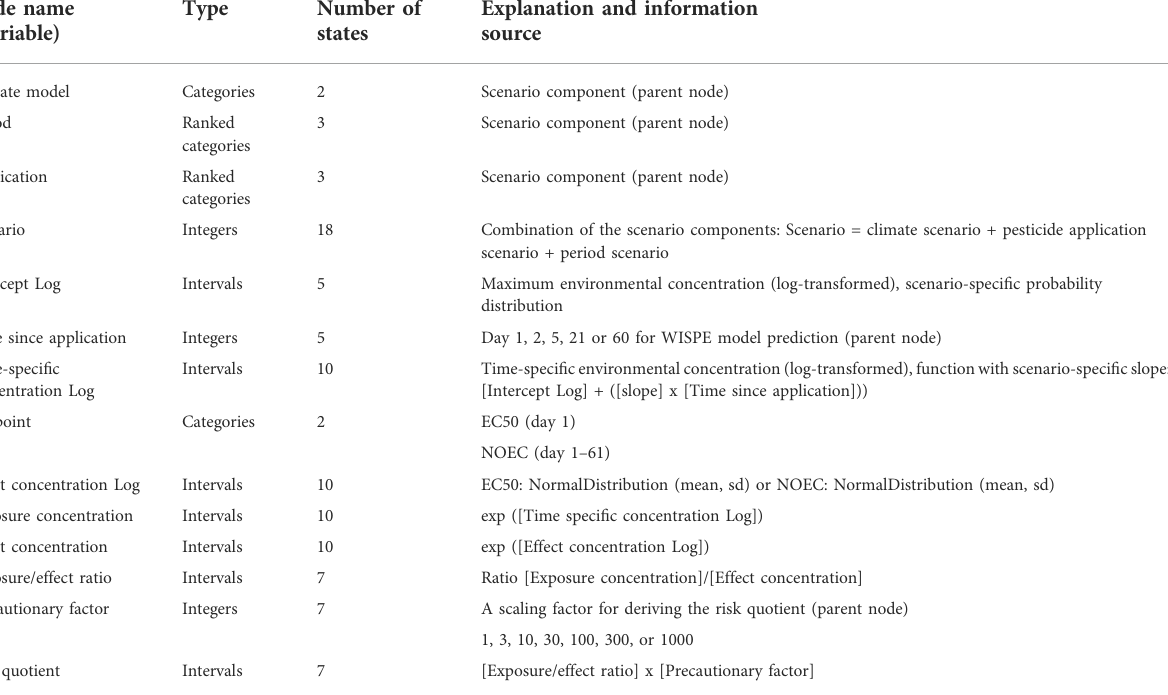
TABLE 1 Bayesian network node description detailing the type of node, the number of states and the method used to parameterize the